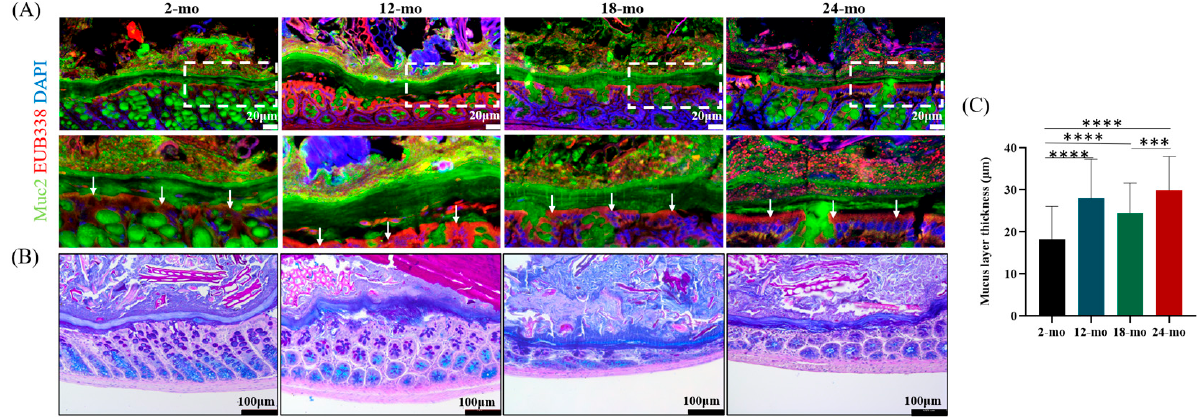
Figure 1. Aged colon showed impaired mucus barrier integrity and increased mucus thickness in mice. ( A ) FISH staining of distal colon sections using EUB338 probes and Muc2 antibodies showed bacterial penetration of the inner mucus layer. The magnified images showed the boxed region. White arrows indicated the apical surface of the epithelial cells. Scale bars: 20 µ m. ( B ) AB/PAS staining images of the distal colons of mice aged 2, 12, 18, and 24 months. Scale bars: 100 µ m. ( C ) Mucus thickness was measured in three colon tissues of mice aged 2, 12, 18, and 24 months (9 measurements per section, 3 sections per mouse). Data were presented as mean ± SD. Data were statistically analyzed using one-way ANOVA with Tukey’s post hoc test. Asterisk indicates significant difference, *** p < 0.001, **** p < 0.0001, n = 3 per